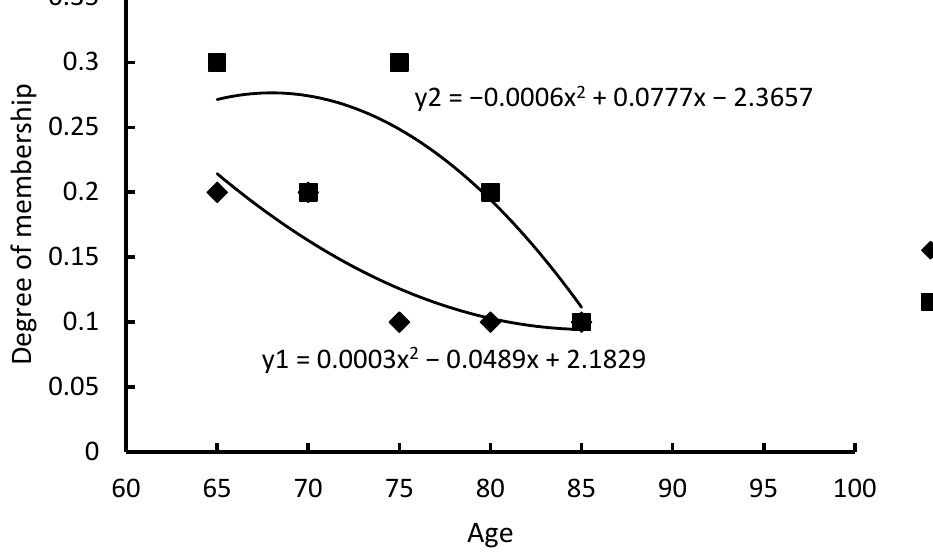
Figure 5. Single factor evaluation for 51–60 years old. In the interval of over 60 years old, the fitting results of y 1 and y 2 are shown in Figure 6, where y 1 = 0.0003 x 2 − 0.0489 x + 2.1829, y 2 = − 0.0006 x 2 + 0.0777 x − 2.3657. Then y 3 = 0.0003 x 2 − 0.0288 x + 1.182 is calculated by Equation (7).